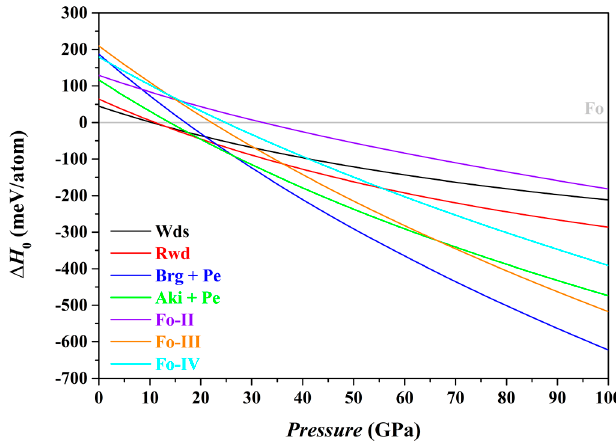
Figure 7. Calculated enthalpies at 0 K ( H 0 : meV/atom) for the phase assemblages of Wds, Rwd, Aki + Pe, Brg + Pe, Fo-II, Fo-III and Fo-IV relative to the enthalpy of the Fo (0–100 GPa). Compared